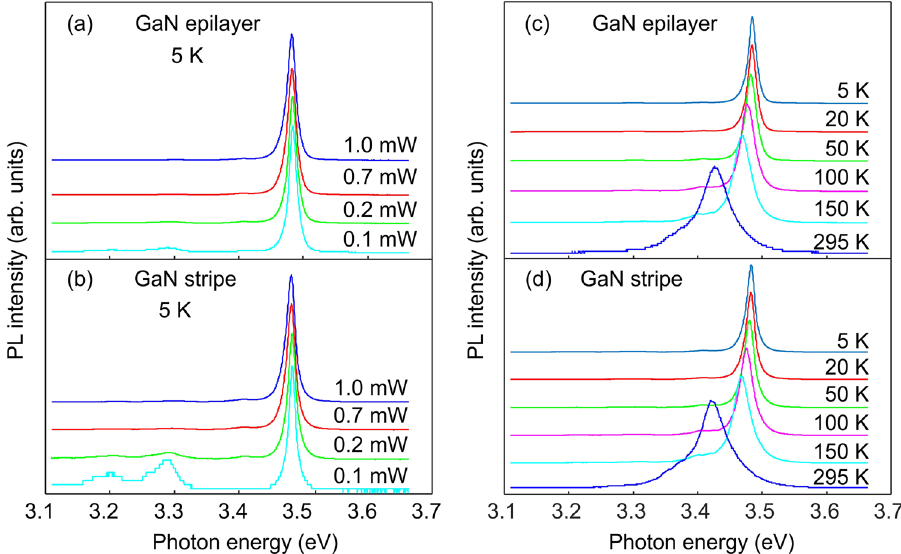
Figure 5. Time-integrated PL spectra taken at 5 K for different excitation power for the bare epitaxial layer ( a ) and for a thin planar GaN nanowire ( b ). Temperature dependent PL spectra for the GaN layer and for the planar GaN nanowire are shown in ( c ) and ( d ), respectively. Spectra are normalized and shifted vertically for